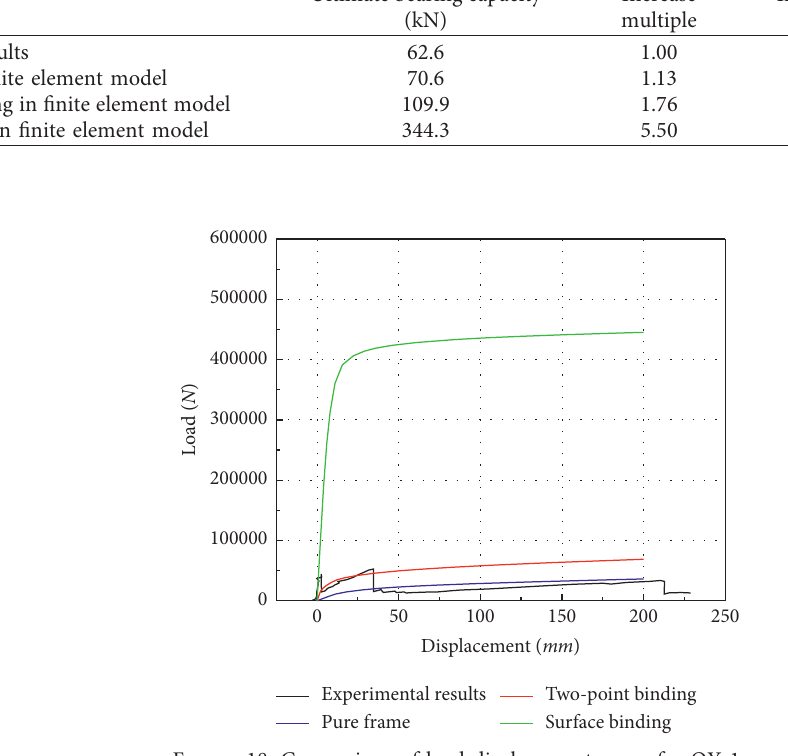
Figure 18: Comparison of load-displacement curve for